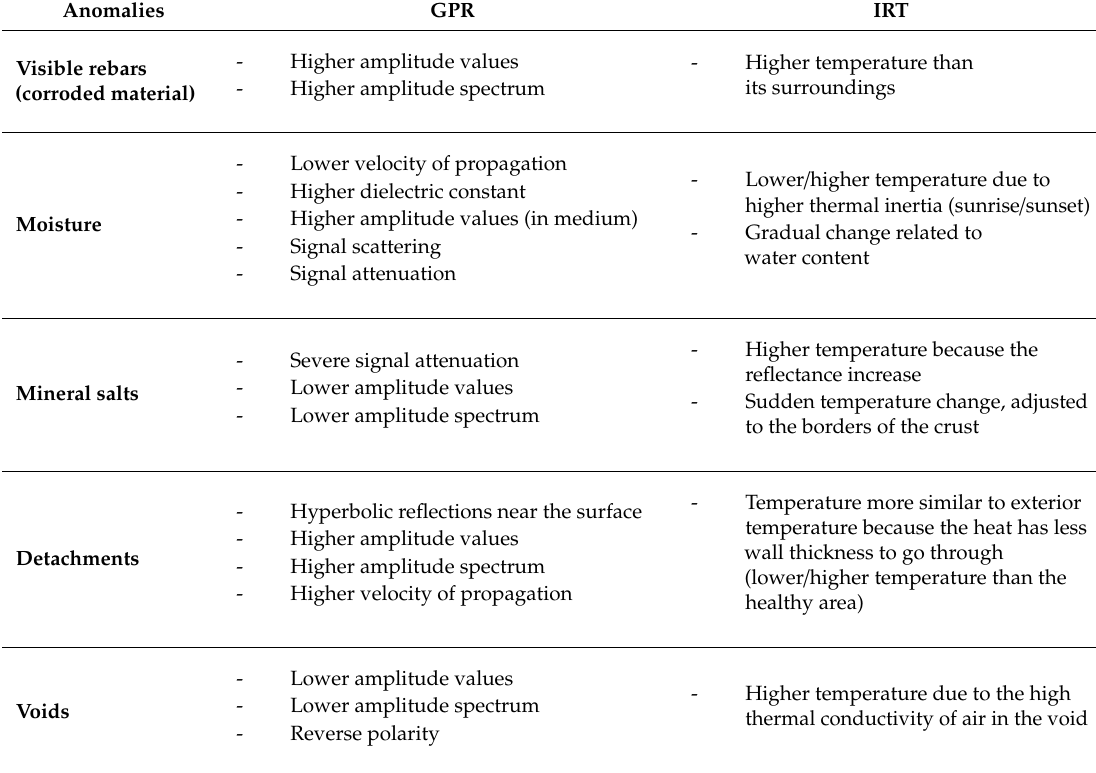
Table 5. Behavior of the GPR signal and the apparent temperature for each